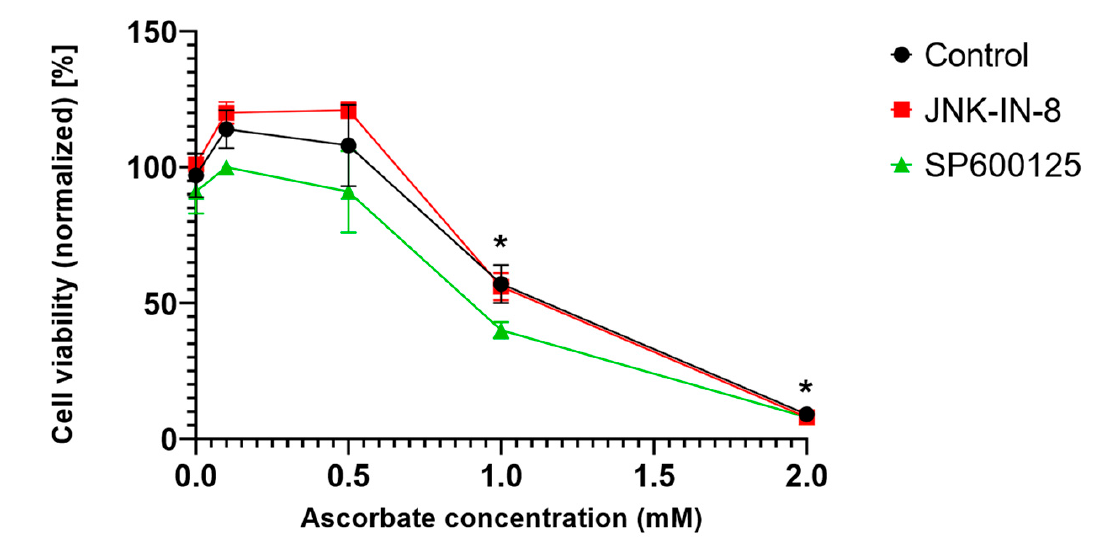
Figure 5. Pharmacological inhibition of JNK activity does not affect ascorbate-induced cell death in HT-1080 cells. HT-1080 cells were treated on a 96-well plate for 24 h with ascorbate (0.1–2 mM). Co-treatment with JNK inhibitors, JNK-IN-8 (10 µM) or SP600125 (5 µM), does not significantly affect the ascorbate-induced cell death. Cell viability was measured by MTT assay. Data are normalized to the untreated control and each data point represents the average ± SD from at least three independent experiments. * Significantly different ( p < 0.05) from untreated.